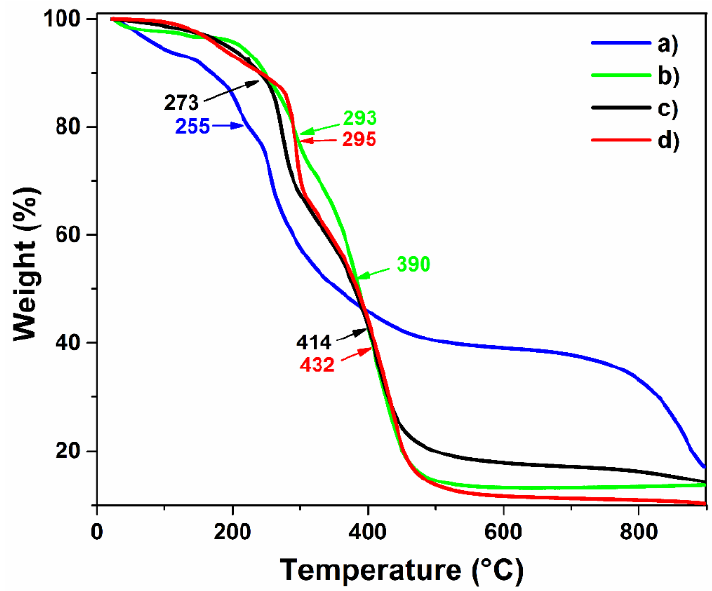
Figure 6. TGA profiles of: ( a ) agar, ( b ) PAAc, ( c ) hydrogel (hydro8), and ( d ) AgNP